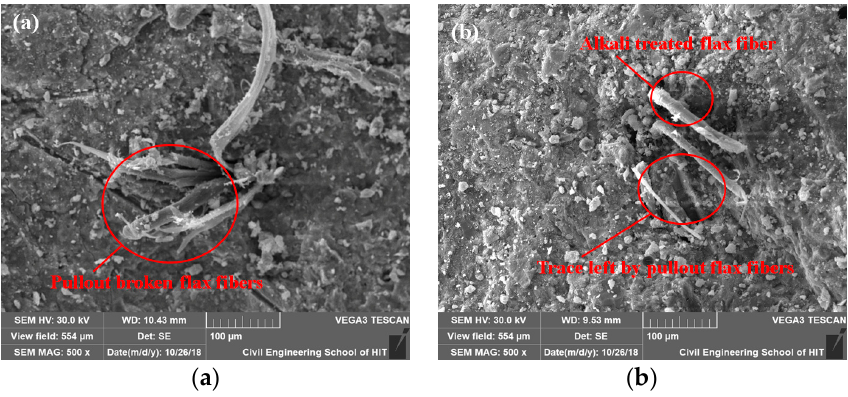
Figure 4. SEM image of the fracture surface of ( a ) F0.5 and ( b ) MF0.5 at 500 × .